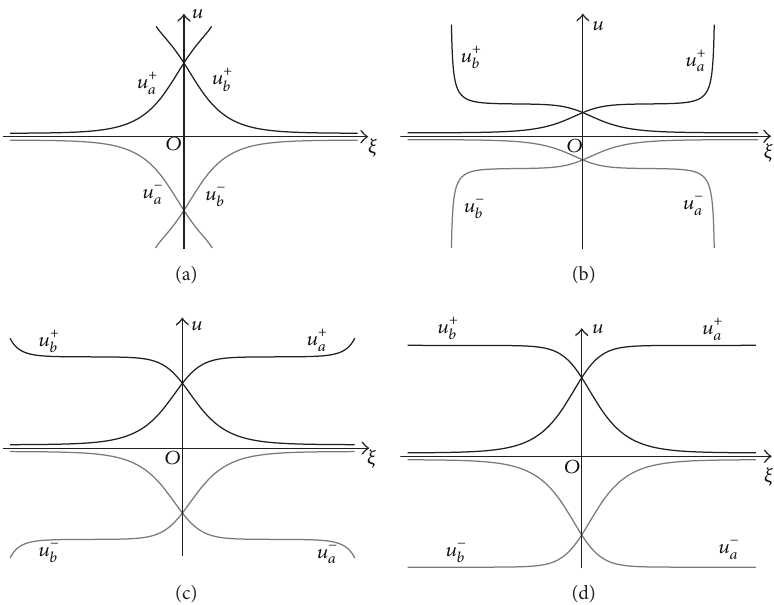
Figure 3: Four low-kink waves are bifurcated from four 1-blow-up waves. The varying process for the figures of 𝑢 ± 𝑎 and 𝑢 ± 𝑏 when 𝜆 > 0 , − 4𝛼 (𝑎,𝑏) ∈ 𝐴 𝑏 → −(5𝑎 2 /48𝑐)−0 ,where 𝜆 = 50 , 𝛾 = 𝛿 = 𝑐 = 𝑎 = 1 ,and(a) 𝑏 = −(5𝑎 2 /48𝑐)−10 −2 ,(b) 𝑏 = −(5𝑎 2 /48𝑐)−10 −5 , 𝜆 ̸= √𝛽 2 1 , 3 ,and 1 (c) 𝑏 = −(5𝑎 2 /48𝑐) − 10 −7 , and (d) 𝑏 = −(5𝑎 2 /48𝑐) − 10 −9